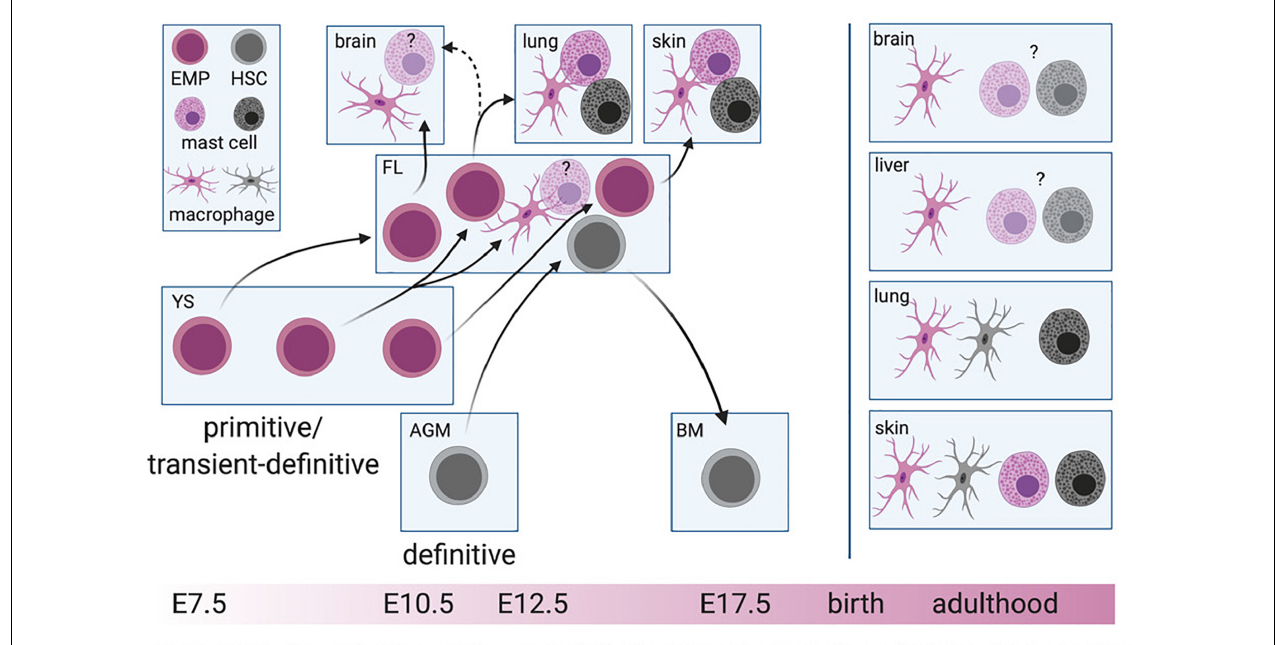
FIGURE 1 | Layered hematopoiesis. The primitive and transient-definitive waves in the yolk sac (YS) give rise to erythro-myeloid progenitors (EMP) that will colonize the fetal liver (FL) consecutively. EMP arising at early stages will differentiate into macrophages and probably mast cells in tissues developing early during embryogenesis (brain, liver), while EMPs at later stages remain in the FL and will give rise to the same cell types driven by the demand of later developing tissues, such as the lung and skin. Hematopoietic stem cells (HSC) develop in the aorta-gonad-mesonephros (AGM) region before colonizing the FL. After the formation of the bone marrow (BM), HSC migrate to the BM cavity where they will constantly give rise to short-lived macrophages and mast cells. The cell of origin for mast cells and macrophages is color-indicated. For simplicity, blood-circulating intermediate precursor stages between EMP and macrophages are not depicted. Created with